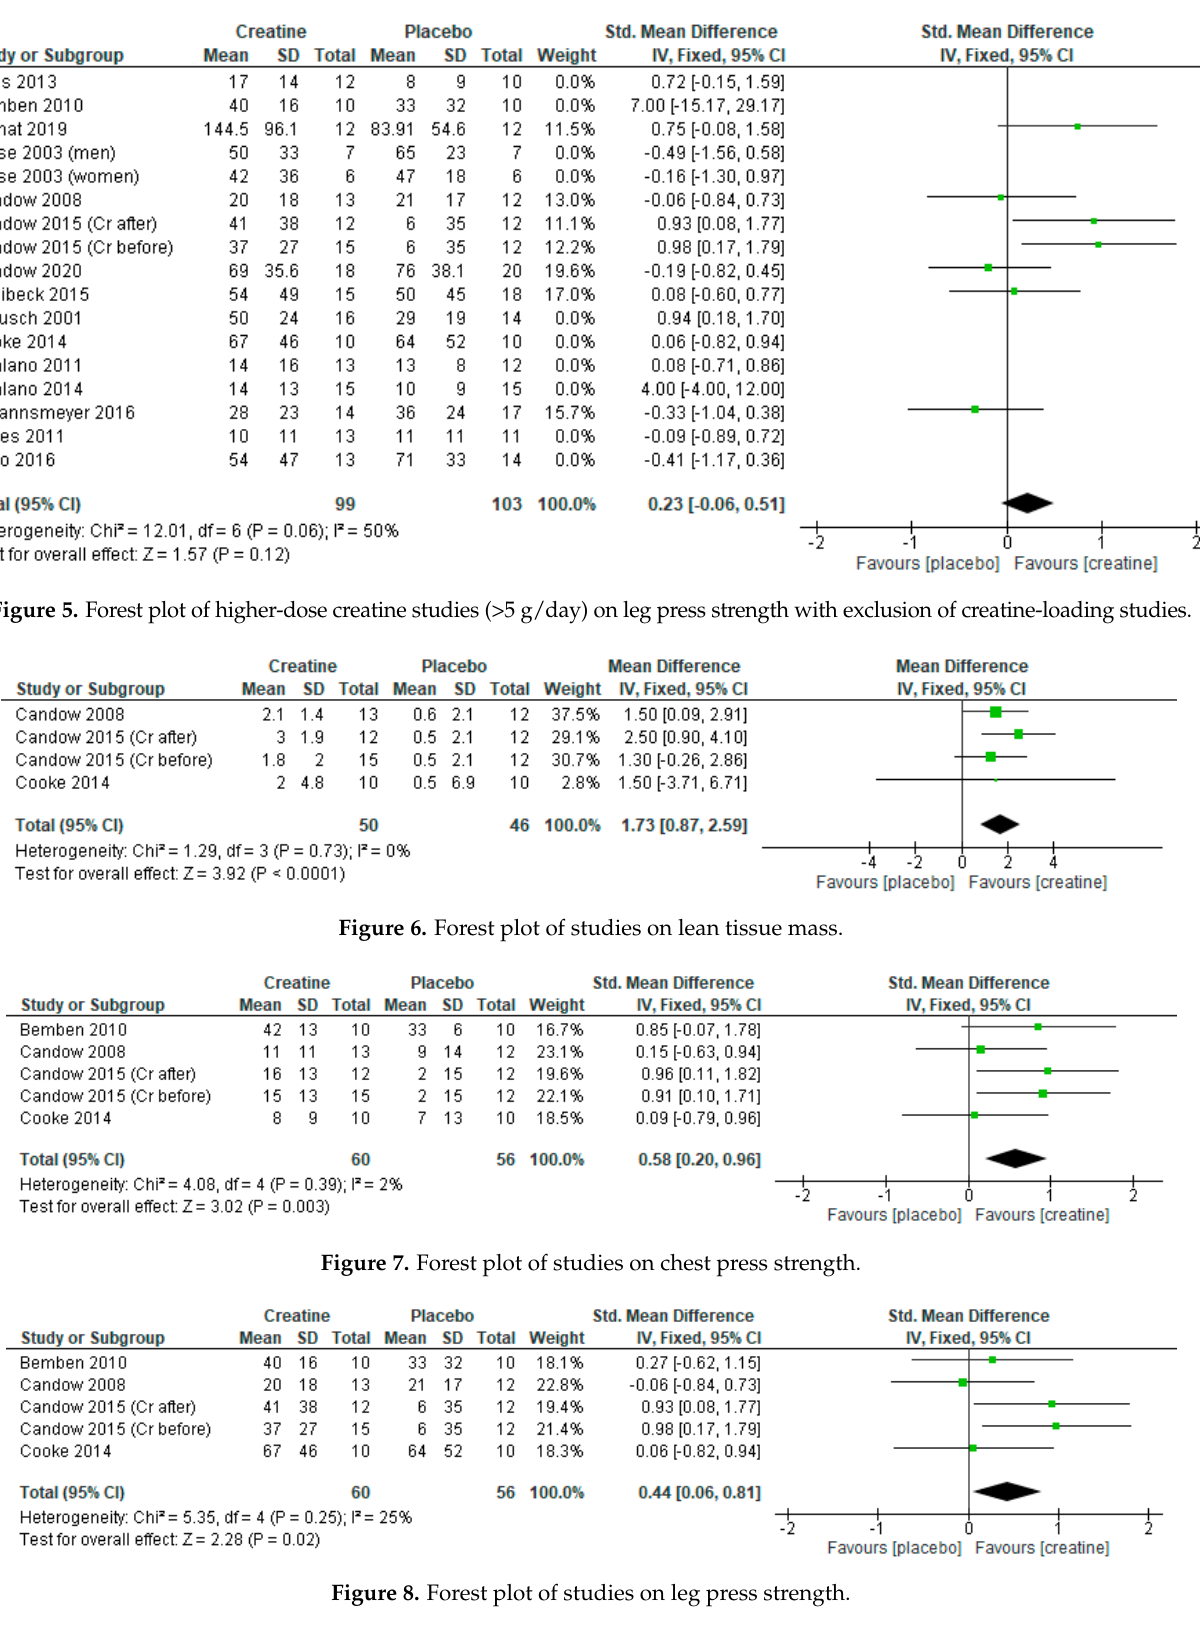
Figure 4. Forest plot of studies on leg press strength.